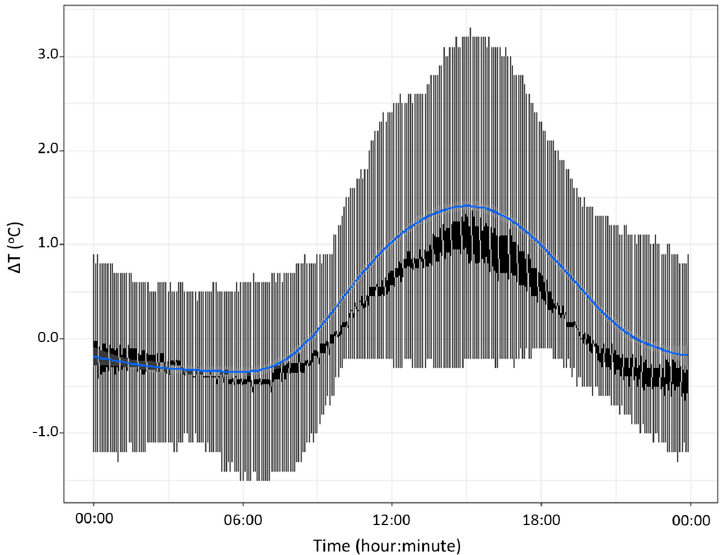
Figure 4. Plot of in-situ soil temperature difference between soil temperature measured in between the tile line and on the tile line, with time of the day in the x -axis. The highest temperature difference between the tile and non-tiled area occurred between 11:00 AM and 6:00 PM local time and peaked ( Δ T~3 ° C) at around 3:00 PM local time.